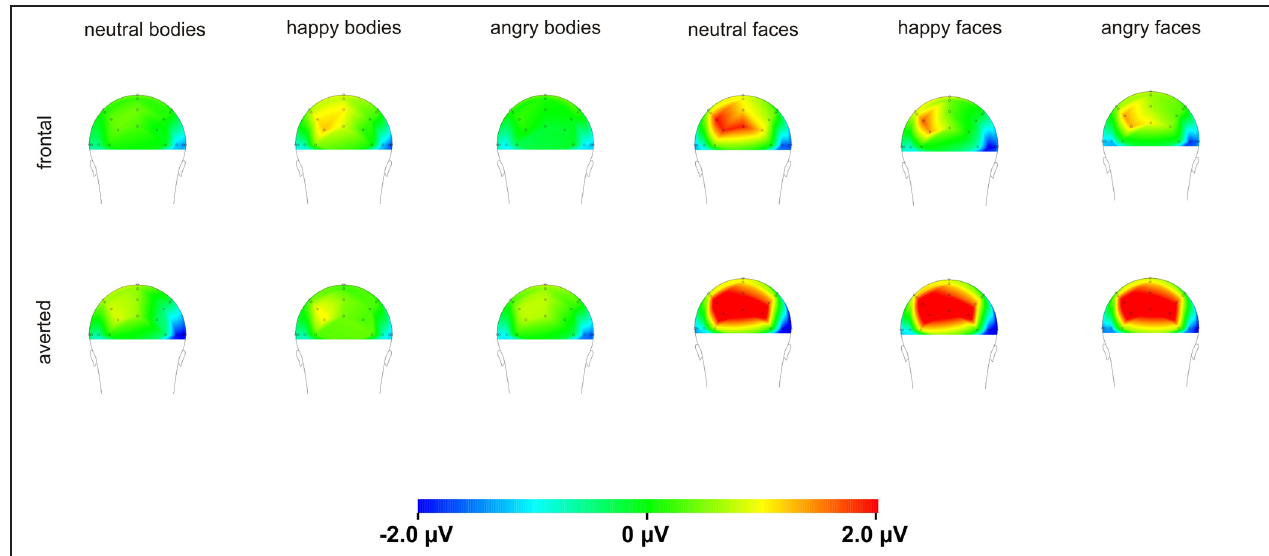
FIGURE 4 | Topography maps of the N170 for bodies and